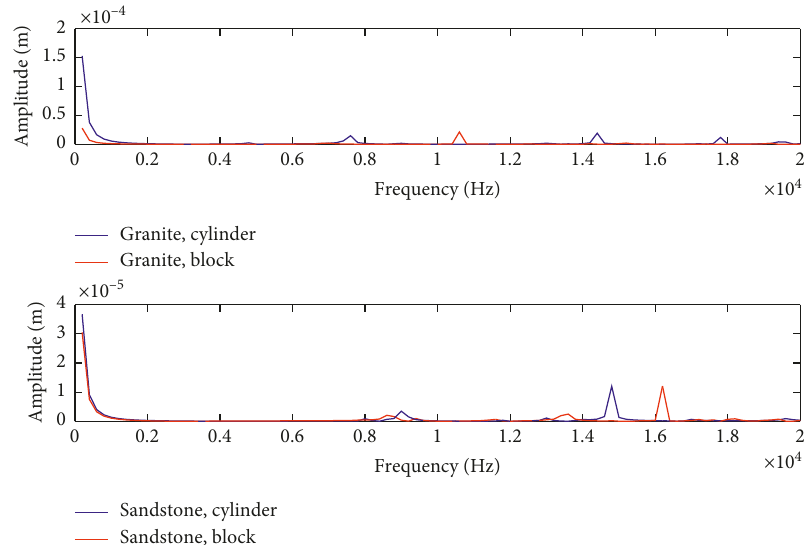
Figure 7: Resonance frequencies of different shapes of rocks: (a) granite; (b) sandstone.